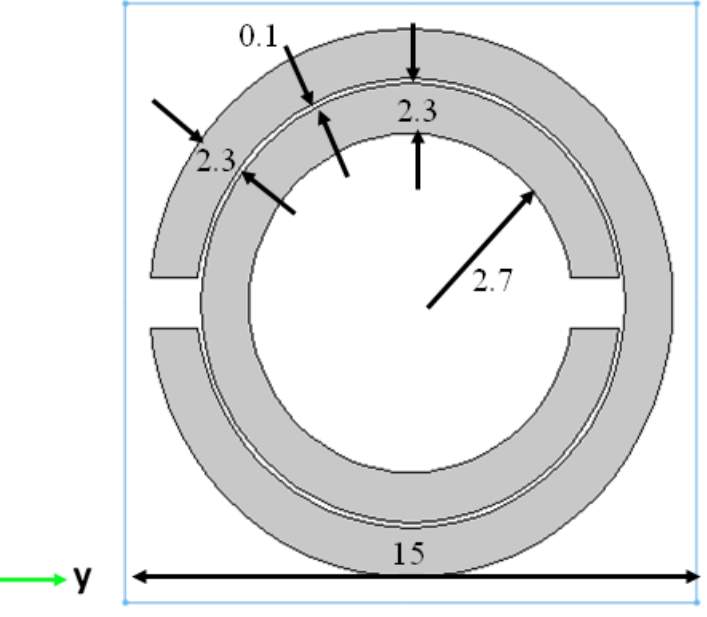
Figure 5. SRR unit cell designed for a C-band resonance (units in